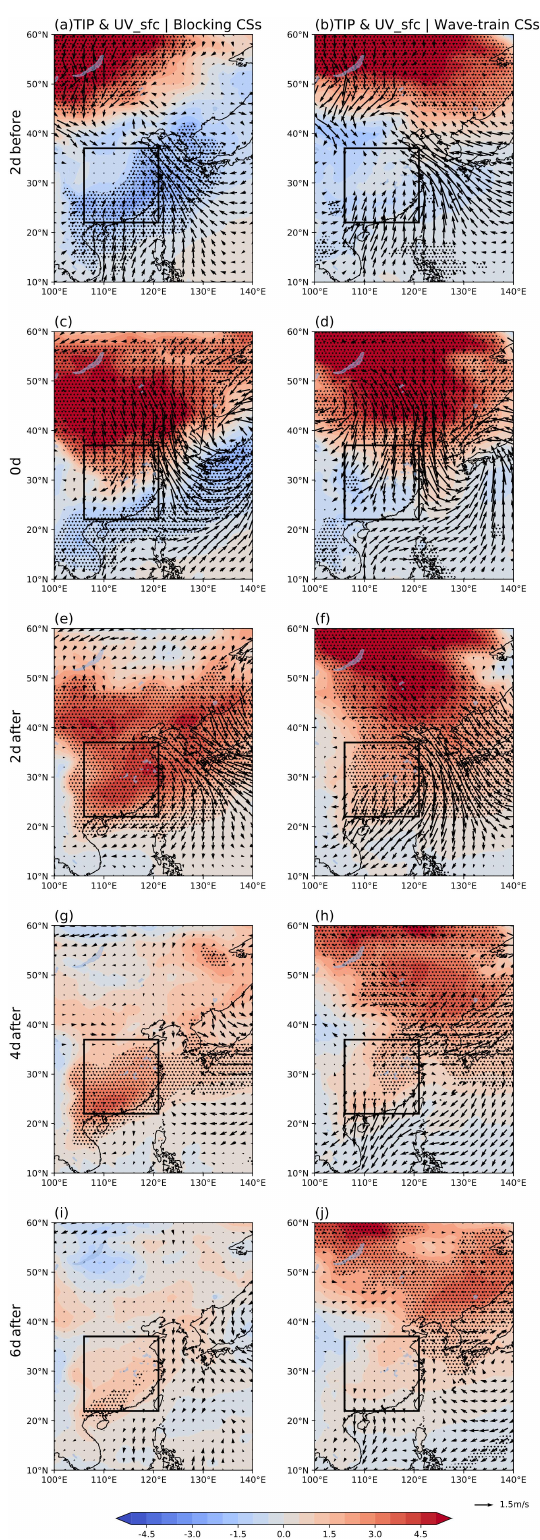
Figure 7. Composite anomalies of TIP (shading; K; dotted areas are statistically significant at the 95% confidence level) and UV_sfc (vectors; ms − 1 ) from − 2 to 6d relative to the outbreak of blocking CSs (a, c, e, g, i) and the wave-train CSs (b, d, f, h, j)